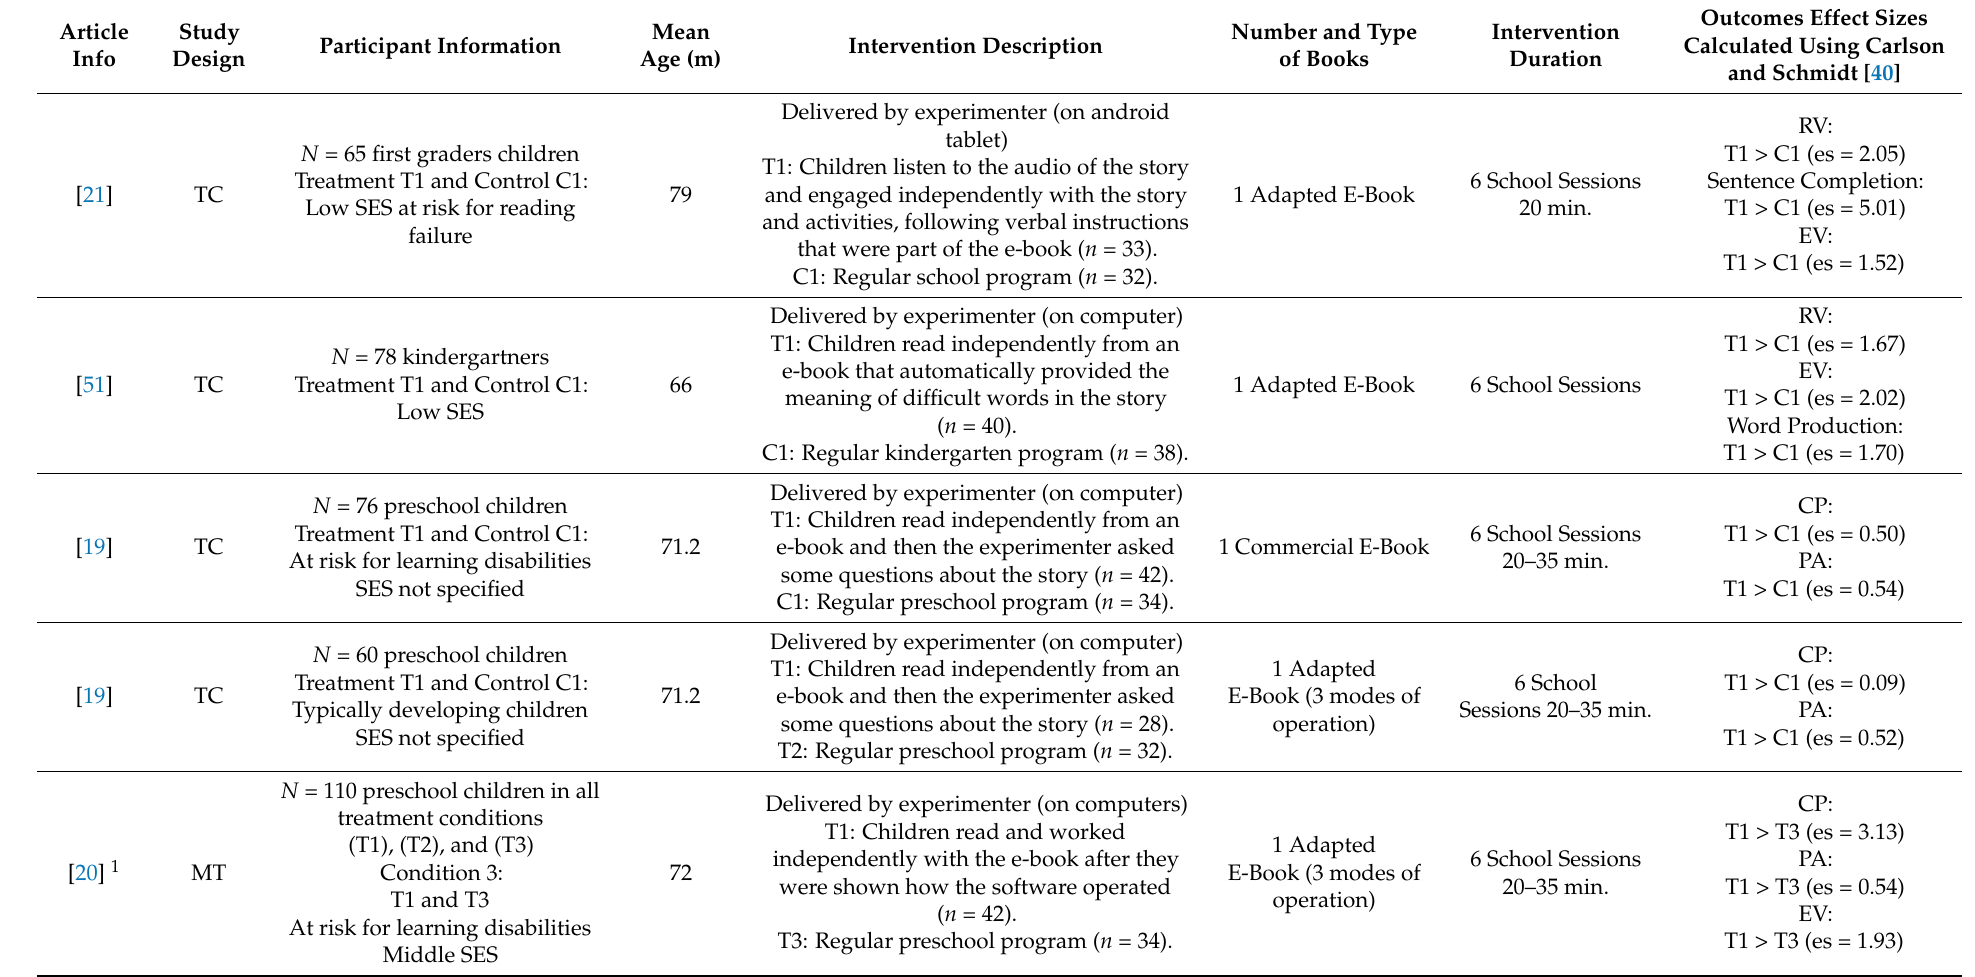
Table 3. Study information (e-book versus the regular school